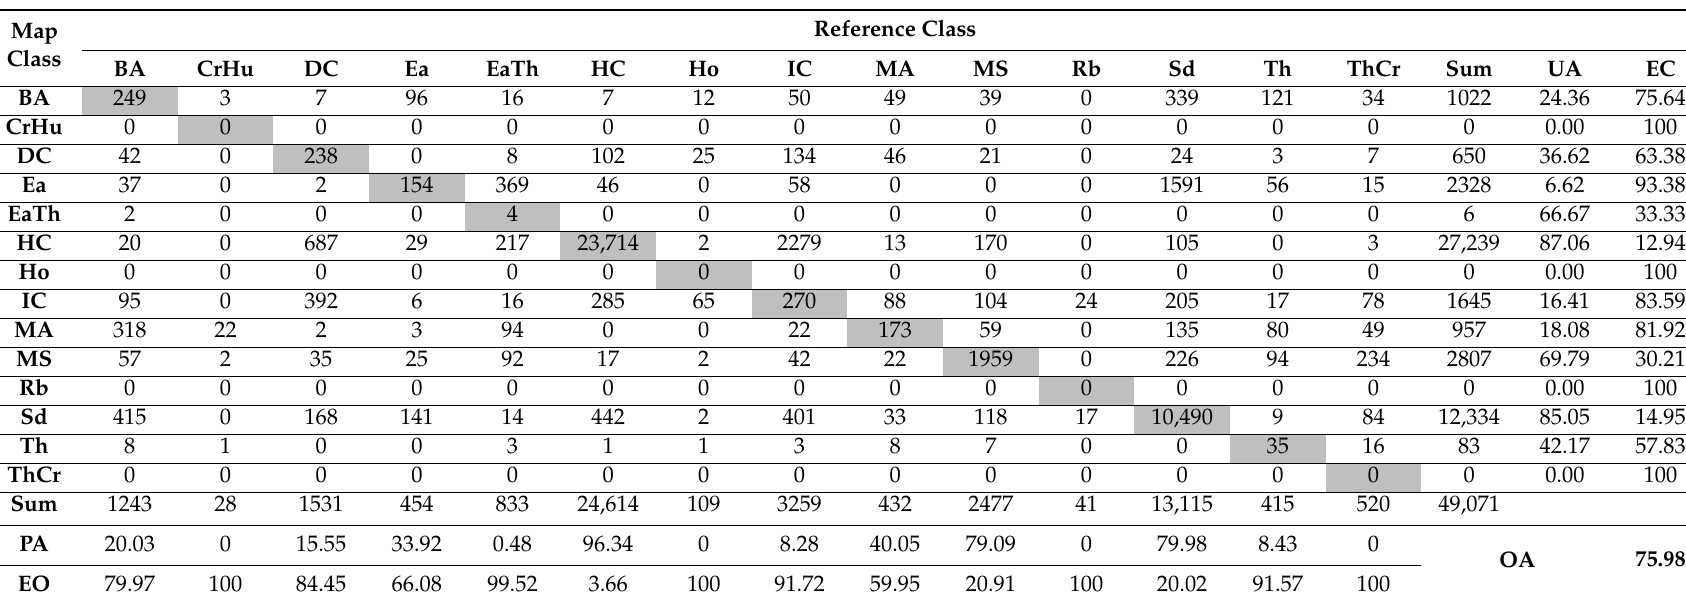
Table 6. Confusion matrix of SVM result. HC: Healthy Coral, IC: Intermediate Coral, DC: Dead Coral, BA: Brown Algae, MA: Mixed-Algae, MS: Mixed-Seagrass, Rb: Rubble, Sd: Sand. OA: Overall Accuracy, UA: User Accuracy, PA: Producer Accuracy, EC: Error Commission, EO: Error